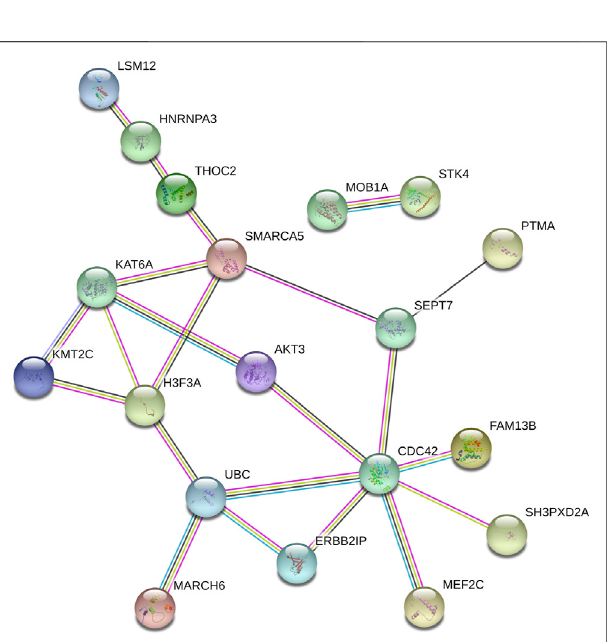
Frontiers in Cell and Developmental Biology |